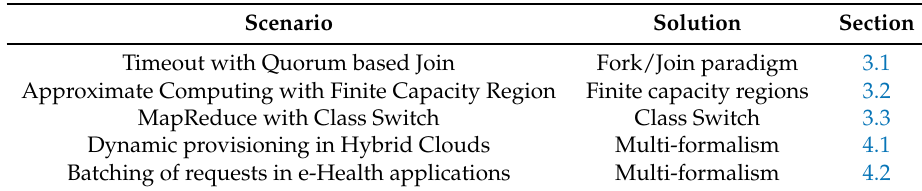
Table 1. Case studies